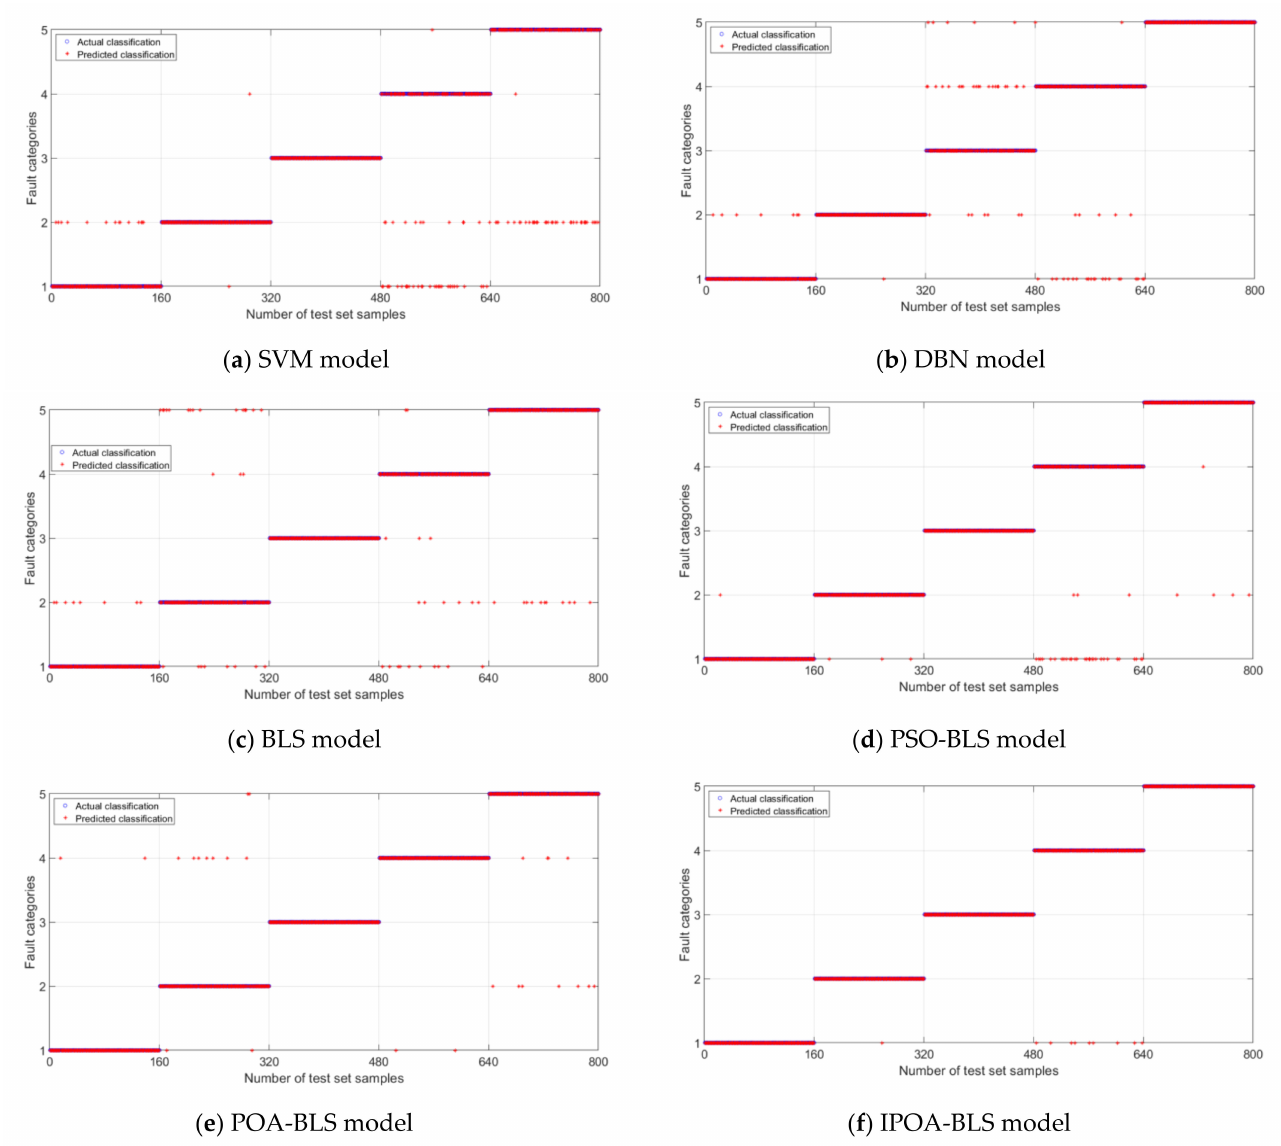
Figure 6. Classification result of the different